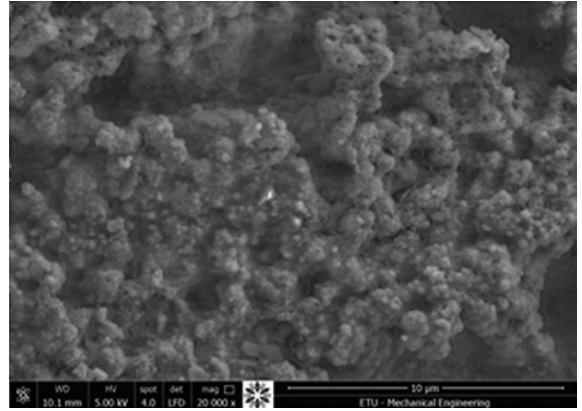
Figure 7: SEM image of gold nanoparticles.